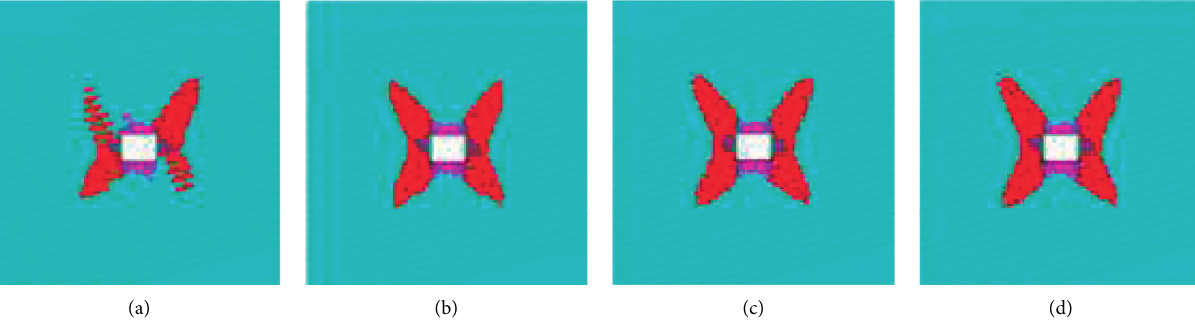
Figure 12: Morphology of plastic zone under different strata internal friction angle. (a) 15 ° . (b) 31 ° . (c) 45 ° . (d) 60 ° .